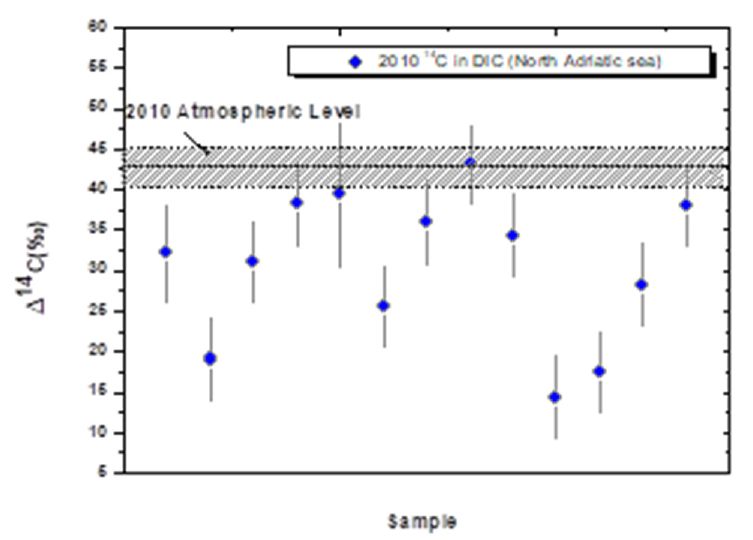
Dissolved Inorganic Carbon (DIC) extracted from sea water (North Adriatic Figure 4. Comparison between the 14 C concentration measured in the 2010 atmosphere and in Dis- solved Inorganic Carbon (DIC) extracted from sea water (North Adriatic Sea).